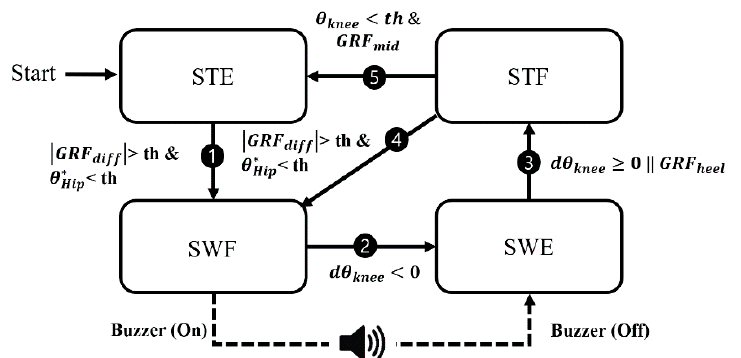
Figure 7. The finite state machine for the developed exoskeletal orthosis gait control. The gait tran- sition starts from the STE (Stance Extension) mode, where (cid:2016) (cid:3009)(cid:3036)(cid:3043)∗ is the opposite side hip